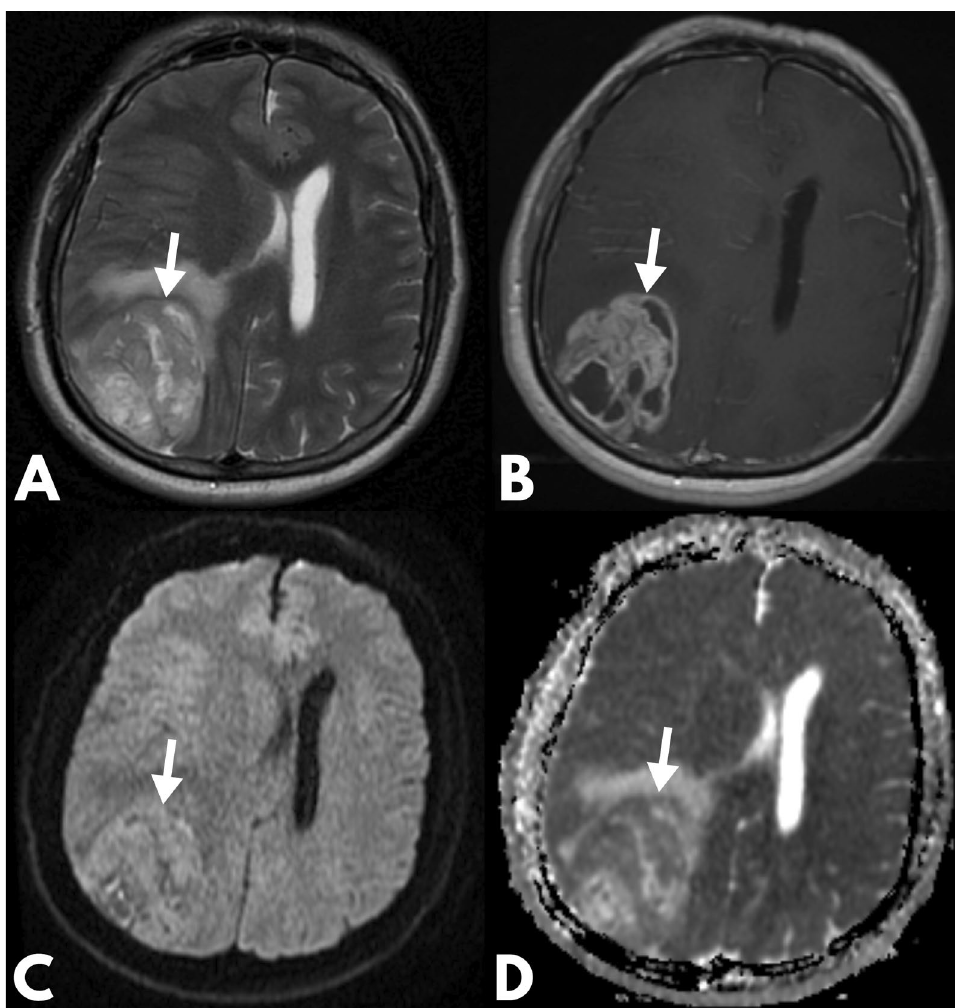
Fig. 3 IDH mutant glial tumour in the right cerebral hemisphere. A: Axial T2-weighted MR image shows a heterogeneous mass, with high and low signals. Vasogenic oedema surrounds the tumour. B: Axial contrast-enhanced T1-weighted image demonstrates a mass with thick, irregular, enhancing walls. C and D: While there is a slight increase in signal in the DWI sequence ( C ), there are low-signal areas in the ADC sequence ( D )